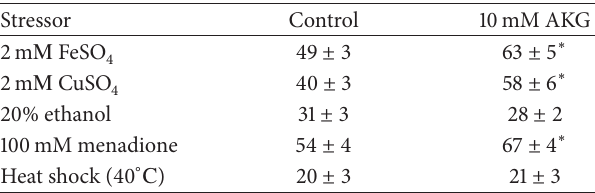
Table 3: Total metabolic activity and selected characteristics of ROS homeostasis in S. cerevisiae YPH250 cells grown in the absence (control) or presence of 10 mM